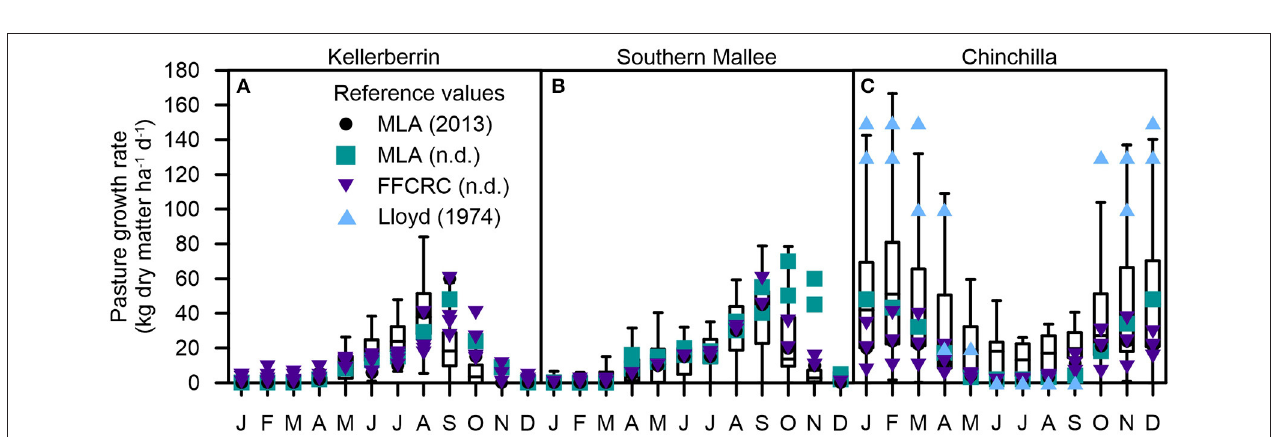
FIGURE 4 | Simulated (box and whisker plots) and reference values (symbols) for pasture growth rates at the (A) Kellerberrin, (B) Southern Mallee, and (C) Chinchilla case study farms. Simulated values include those from both the Livestock grass (grass pasture receiving 12.5–50kg N fertilizer ha − 1 yr − 1 ) and Livestock legume (legume pasture) scenarios because pastures are subjected to the same temperatures and rainfall influencing pasture growth. “Whiskers” in the box and whisker plots are provided for 1.5 × the interquartile